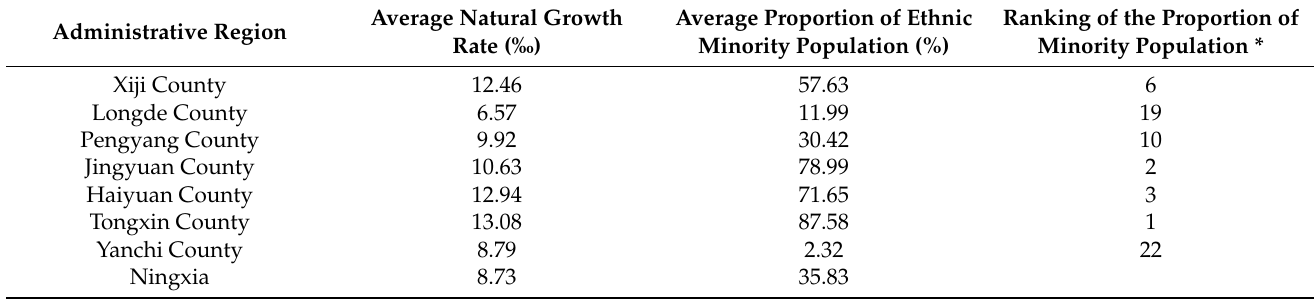
Administrative Region